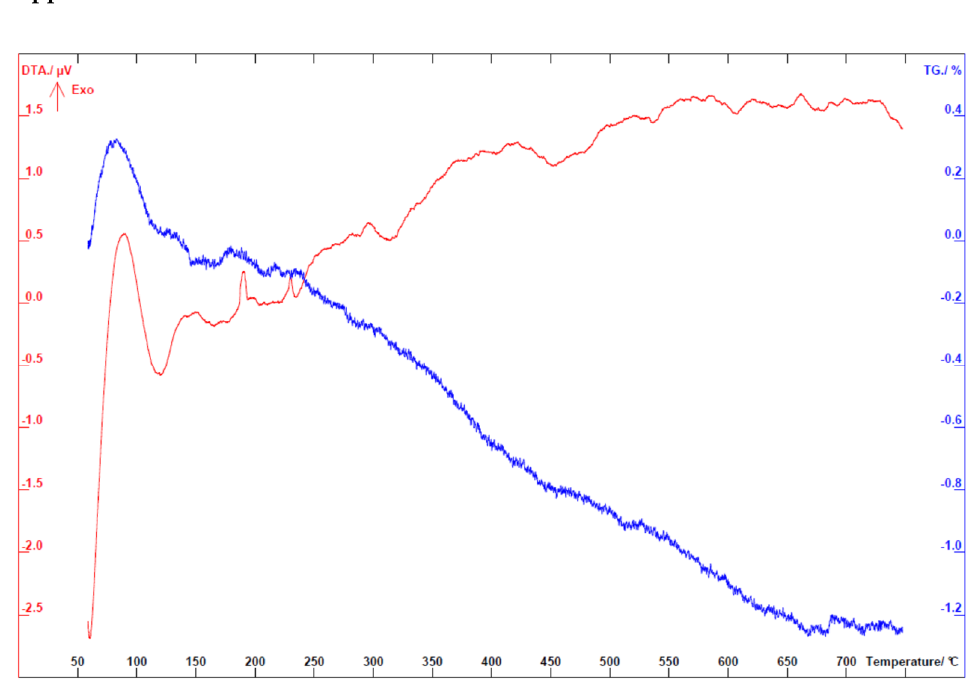
Figure A1. Differential thermal analysis (DTA) and thermogravimetric (TG) analysis curves recorded in air on graphite coated Al 2 O 3 substrate.